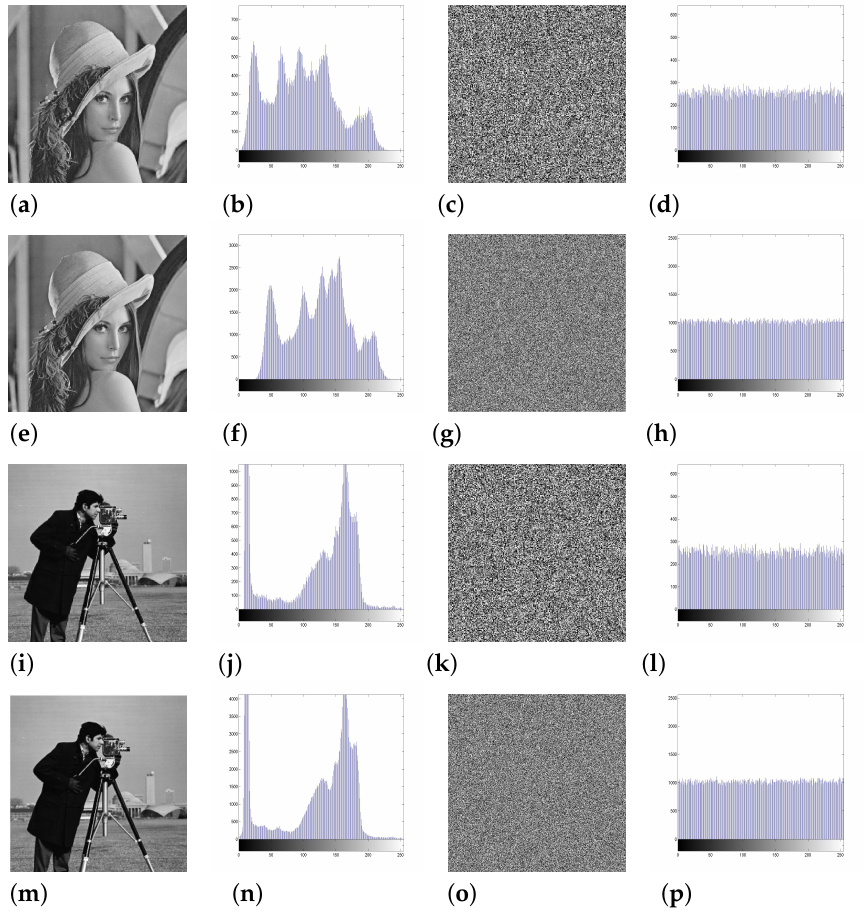
Figure 4. Histogram analysis: the plain images (( a ) Lena ( 256 ( i ) Cameraman ( 256 256 ) , and ( m ) Cameraman ( 512 × the corresponding enciphered images ( c , g , k , o ) and their corresponding histograms ( d , h , l , p